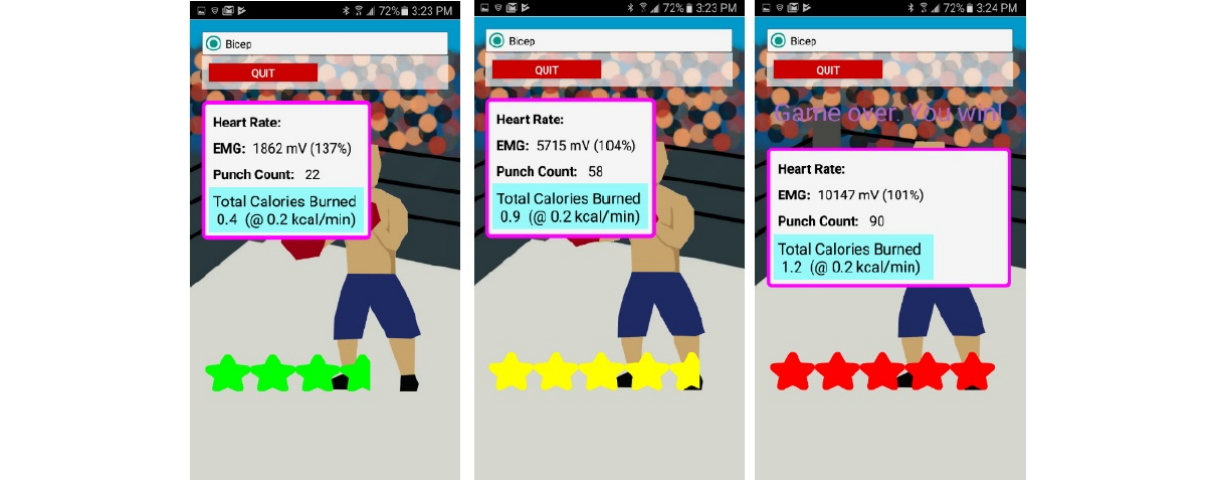
Figure 5. Sequence of screenshots during the boxing game. Each round gets progressively more difficult (the threshold for a punch being detected